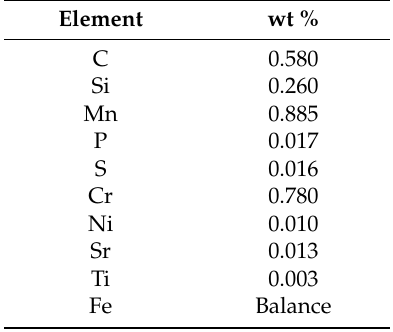
Table 1. Chemical composition of AISI 5160